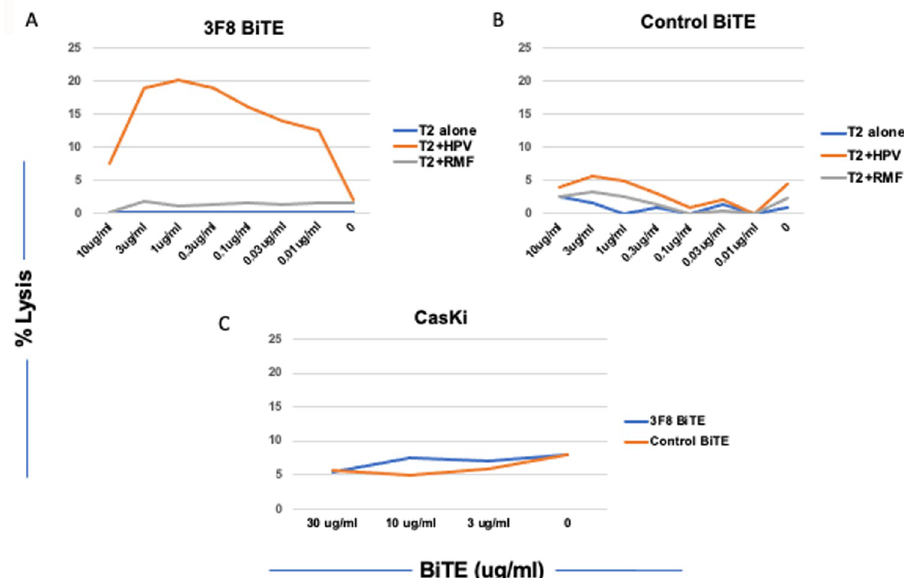
Fig 5. Cytotoxicity of the 3F8 BiTE. T2 cells alone, or pulsed with HPV-E7p11-19 or RMF control peptide at 50ug/ml were incubated with human PBMCs at E:T ratio of 20:1 and the 3F8 BiTE [Fig 5A], or control BiTE [Fig 5B] at indicated concentrations for 5 hrs and the cytotoxicity was measured by 51 Cr-release assay. Similarly, 3F8 BiTE was tested for its cytotoxicity against CasKi [Fig 5C] without HPV E7-11 peptide pulsing at indicated concentrations. Each data point is the average of triplicate cultures and representative of three similar experiments.